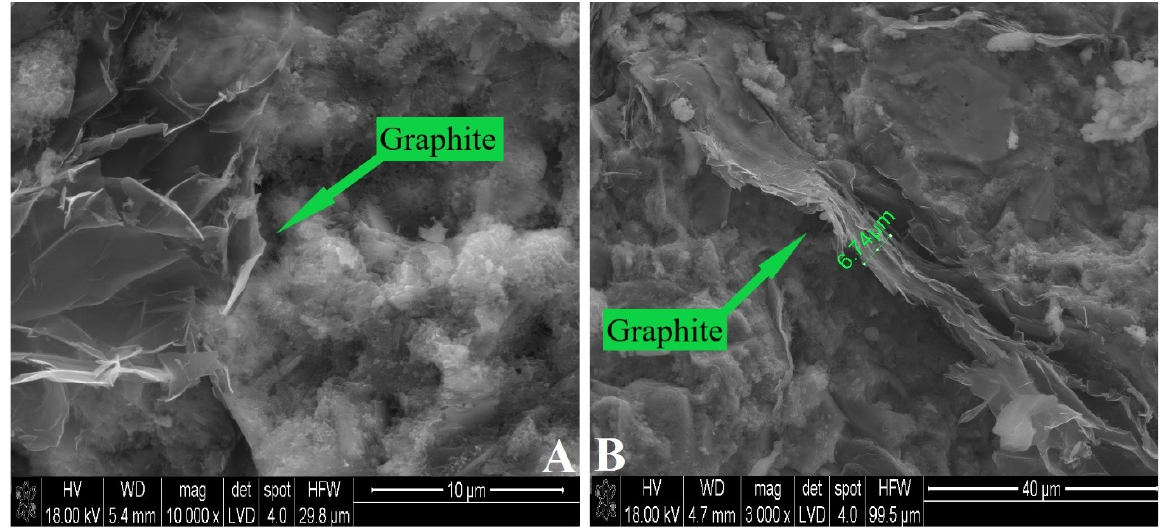
Figure 4. SEM images of cement composites with graphite content: ( A ) 2 wt% and ( B ) 3